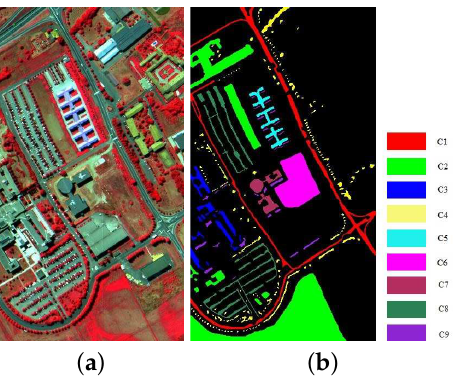
Figure 6. ( a ) False color hyperspectral data over the University of Pavia (using bands 105, 63, and 29). ( b ) Ground truth of the labeled area with nine classes of land cover: Asphalt, meadows, gravel, trees, painted metal sheets, bare soil, bitumen, self-blocking bricks, and shadows.